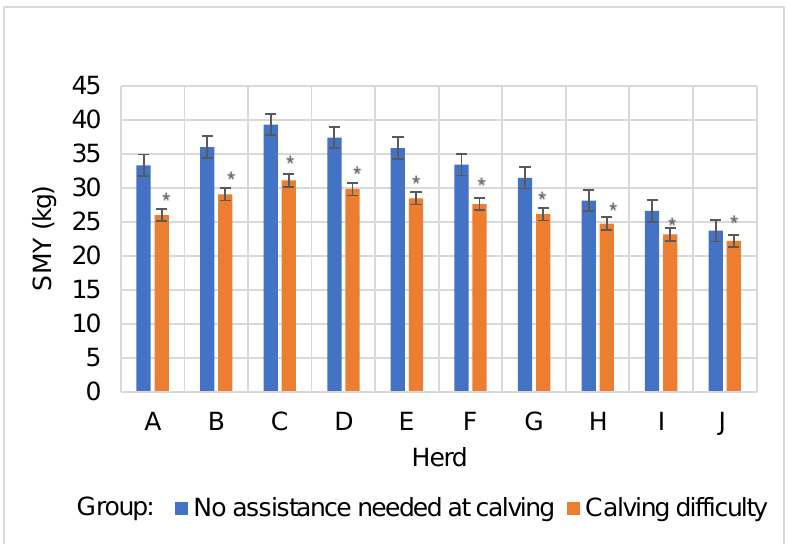
Figure 2. Standard milk yield of cows with and without assistance needed at calving from 1 to 30 days after calving in different herds. SMY: standard milk yield (0.4 × MY + 15 × MF × MY); Means within a herd that are marked with an * differ by p < 0.05. A–J—Herd. On average, the daily milk yield was higher by 1.24 kg ( p = 0.007), milk protein ( p = 0.044) was higher by 0.04%, milk lactose was higher by 2.1% ( p < 0.001) in non-lame cows as compared with lame cows, whereas no differences were observed in the mean fat content value between the groups. The number of somatic cells, CD, was lower in non-lame cows (Table 4). Table 4. Milk yield and composition and somatic cell count in non-lame and lame cows. Non-Lame Cows Lame Cows Trait